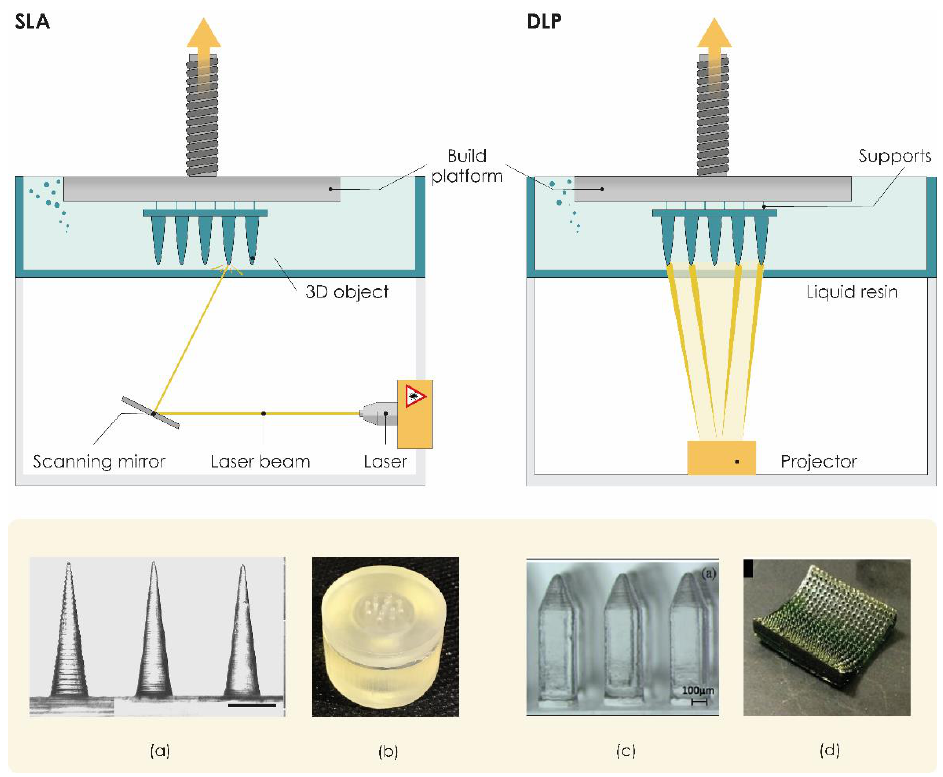
Figure 3. The working principle of stereolithography (SLA) and digital light projection (DLP). ( a , b ) Microneedles manufactured by SLA. Reproduced with permission from [122,123], Springer Nature, 2019 and MDPI, 2018. ( c , d ) Microneedles manufactured by the DLP technique. Reproduced with permission from [124,125], IOP Publishing, Ltd., Bristol, UK, 2015, 2020 The image was created with Adobe Illustrator CC (Version 23.0.1.; Adobe Inc., San Jose, CA, USA, 2019).